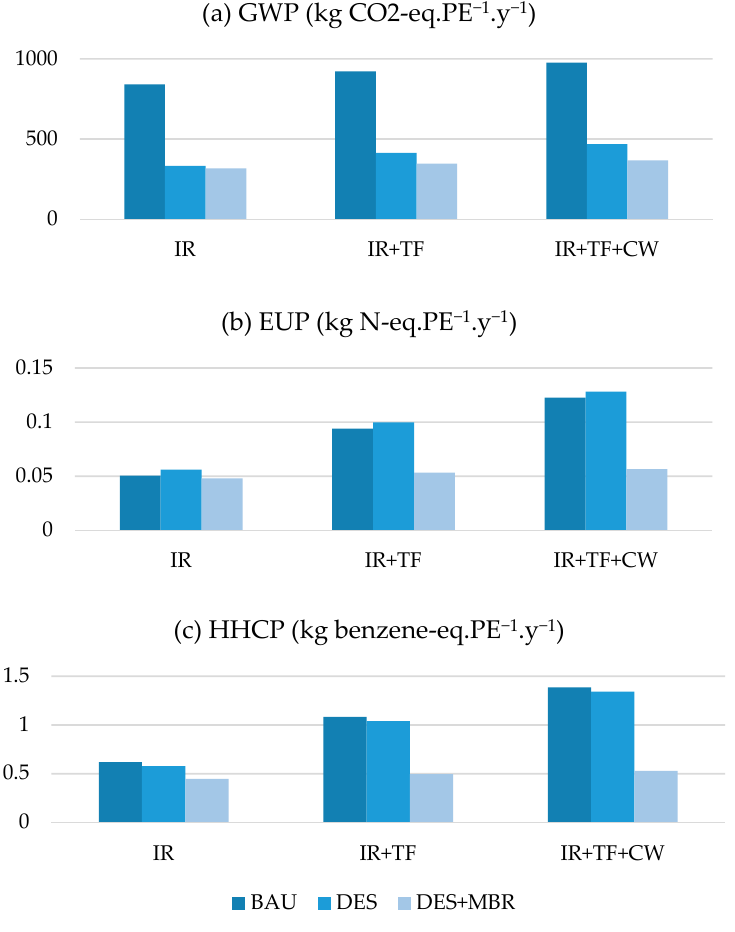
Figure 2. Comparison of business as usual (BAU), district energy system (DES) and district energy system with membrane bioreactor treatment (DES + MBR) for impact categories: ( a ) global warming potential (GWP); ( b ) eutrophication potential (EUP), and ( c ) human health carcinogenic potential (HHCP) for different water reuse scenarios.